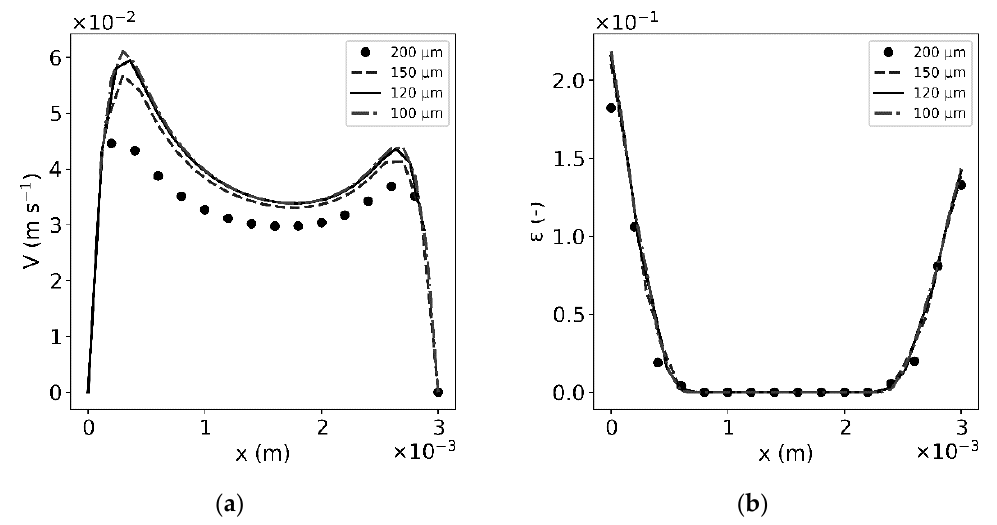
Figure 2. Results of the mesh sensitivity study. The graph ( a ) presents the mesh dependence of the velocity. The graph ( b ) presents the mesh dependence of the void fraction.